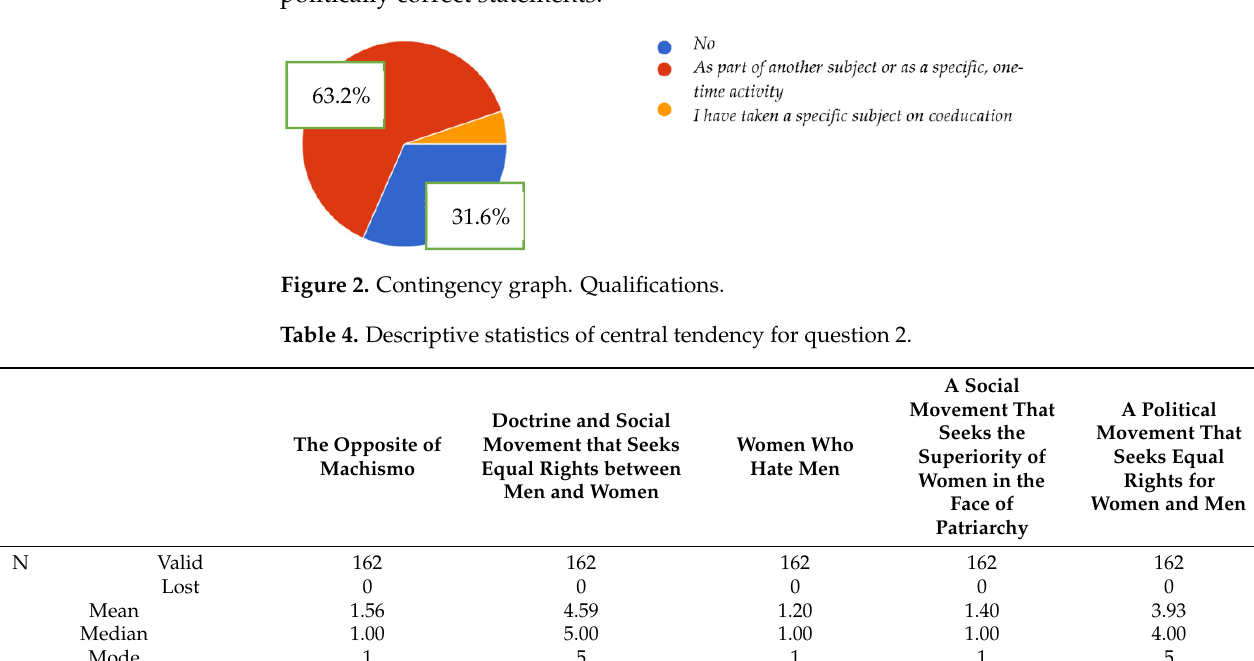
Table 4. Descriptive statistics of central tendency for question 2.